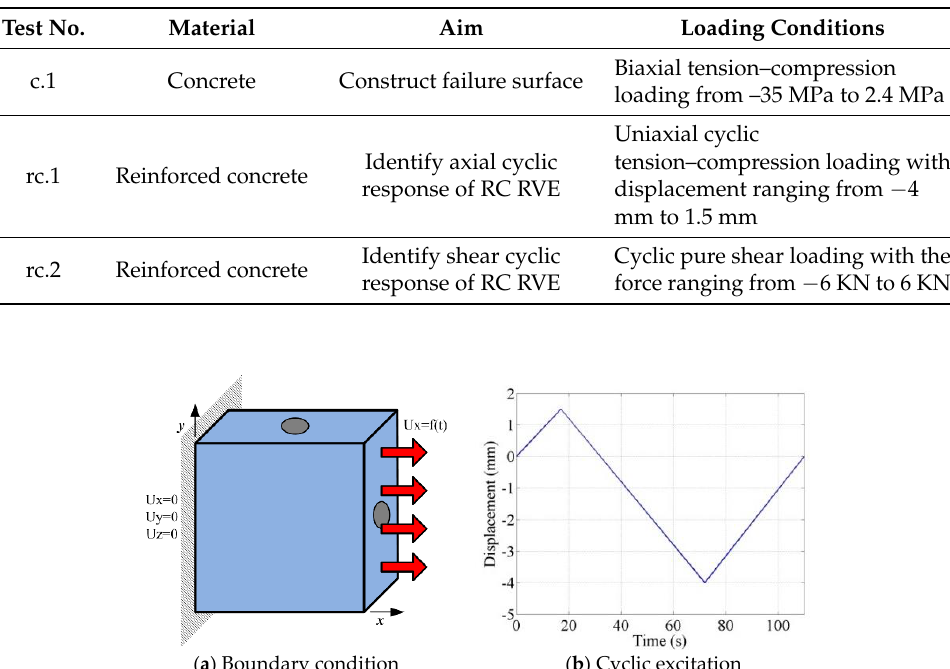
Figure 10. Local test rc.1: uniaxial cyclic displacement loading.